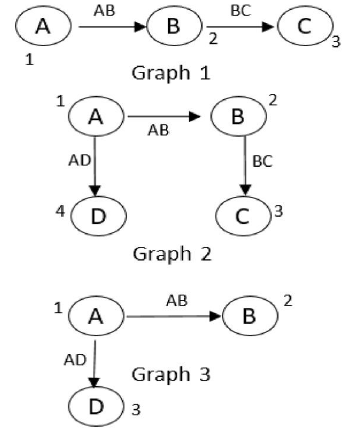
Fig. 19 DB-FSG example